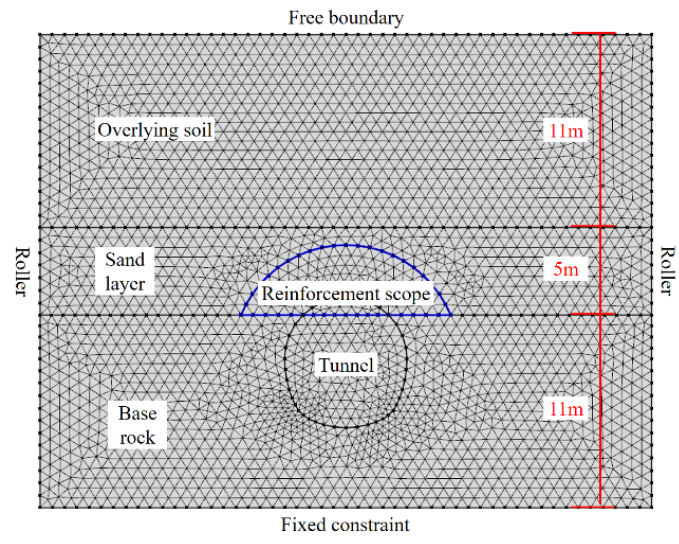
Figure 17. Calculation model.